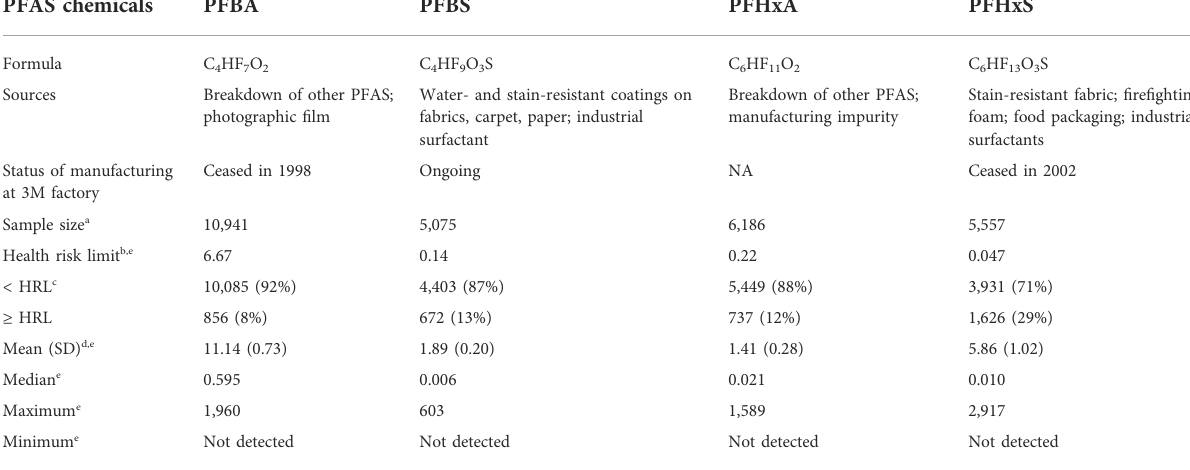
TABLE 1 Four short-chain PFAS investigated in this